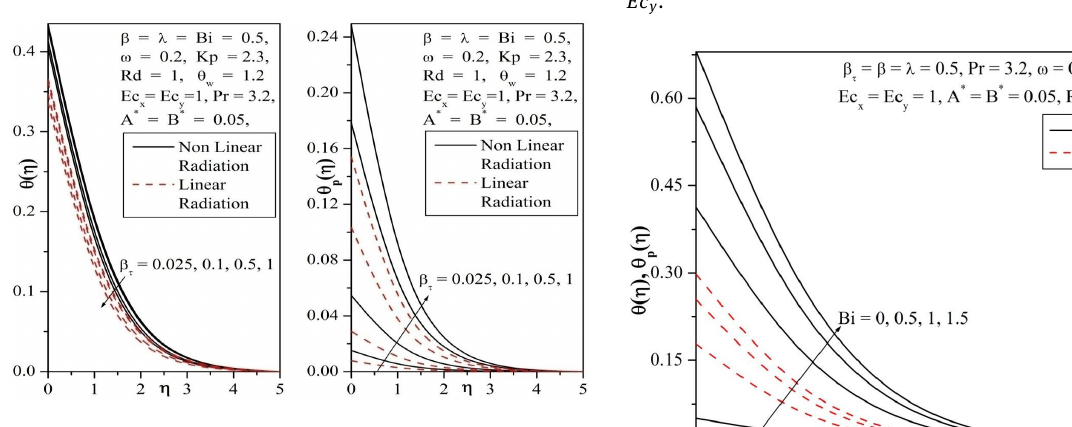
Fig. 13: Dimensionless temperature profiles for different values of β τ .